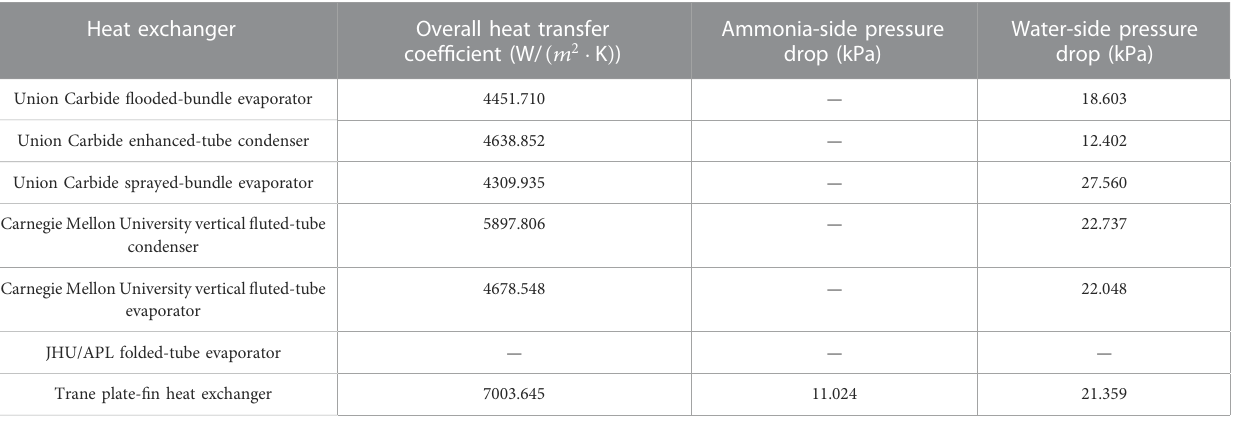
TABLE 1 Test results for seven heat